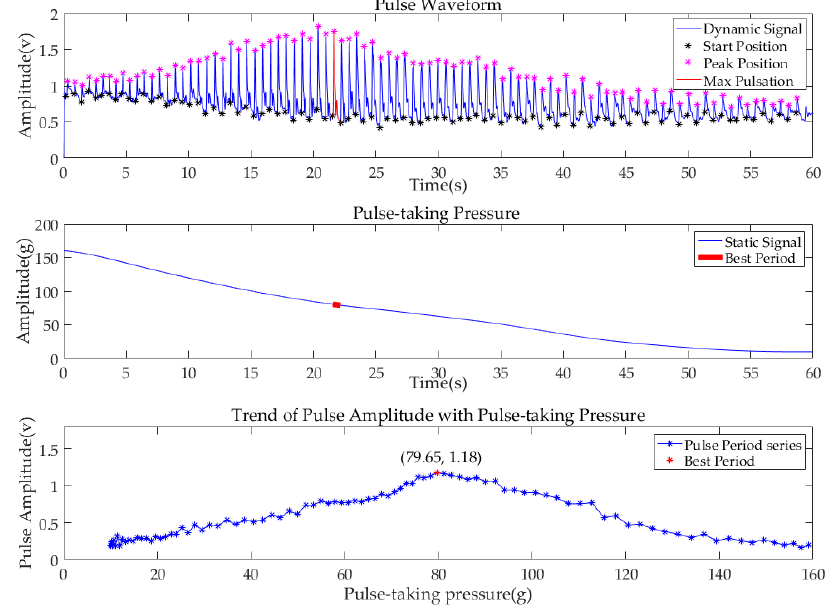
Figure 10. Pulse diagrams of subject (No.6) at the Cun region.